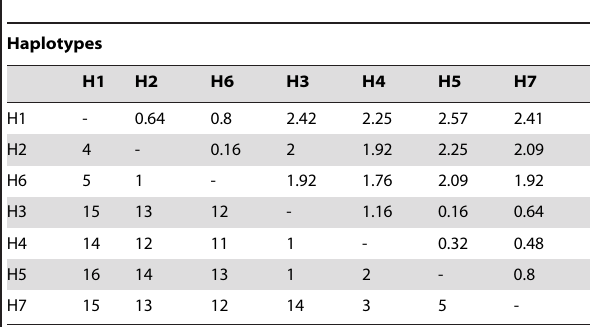
Table 3. Nucleotide substitutions (below diagonal) and p - uncorrected distances (%) (above diagonal) for each pairwise comparison for all C. emmae haplotypes in the transect.